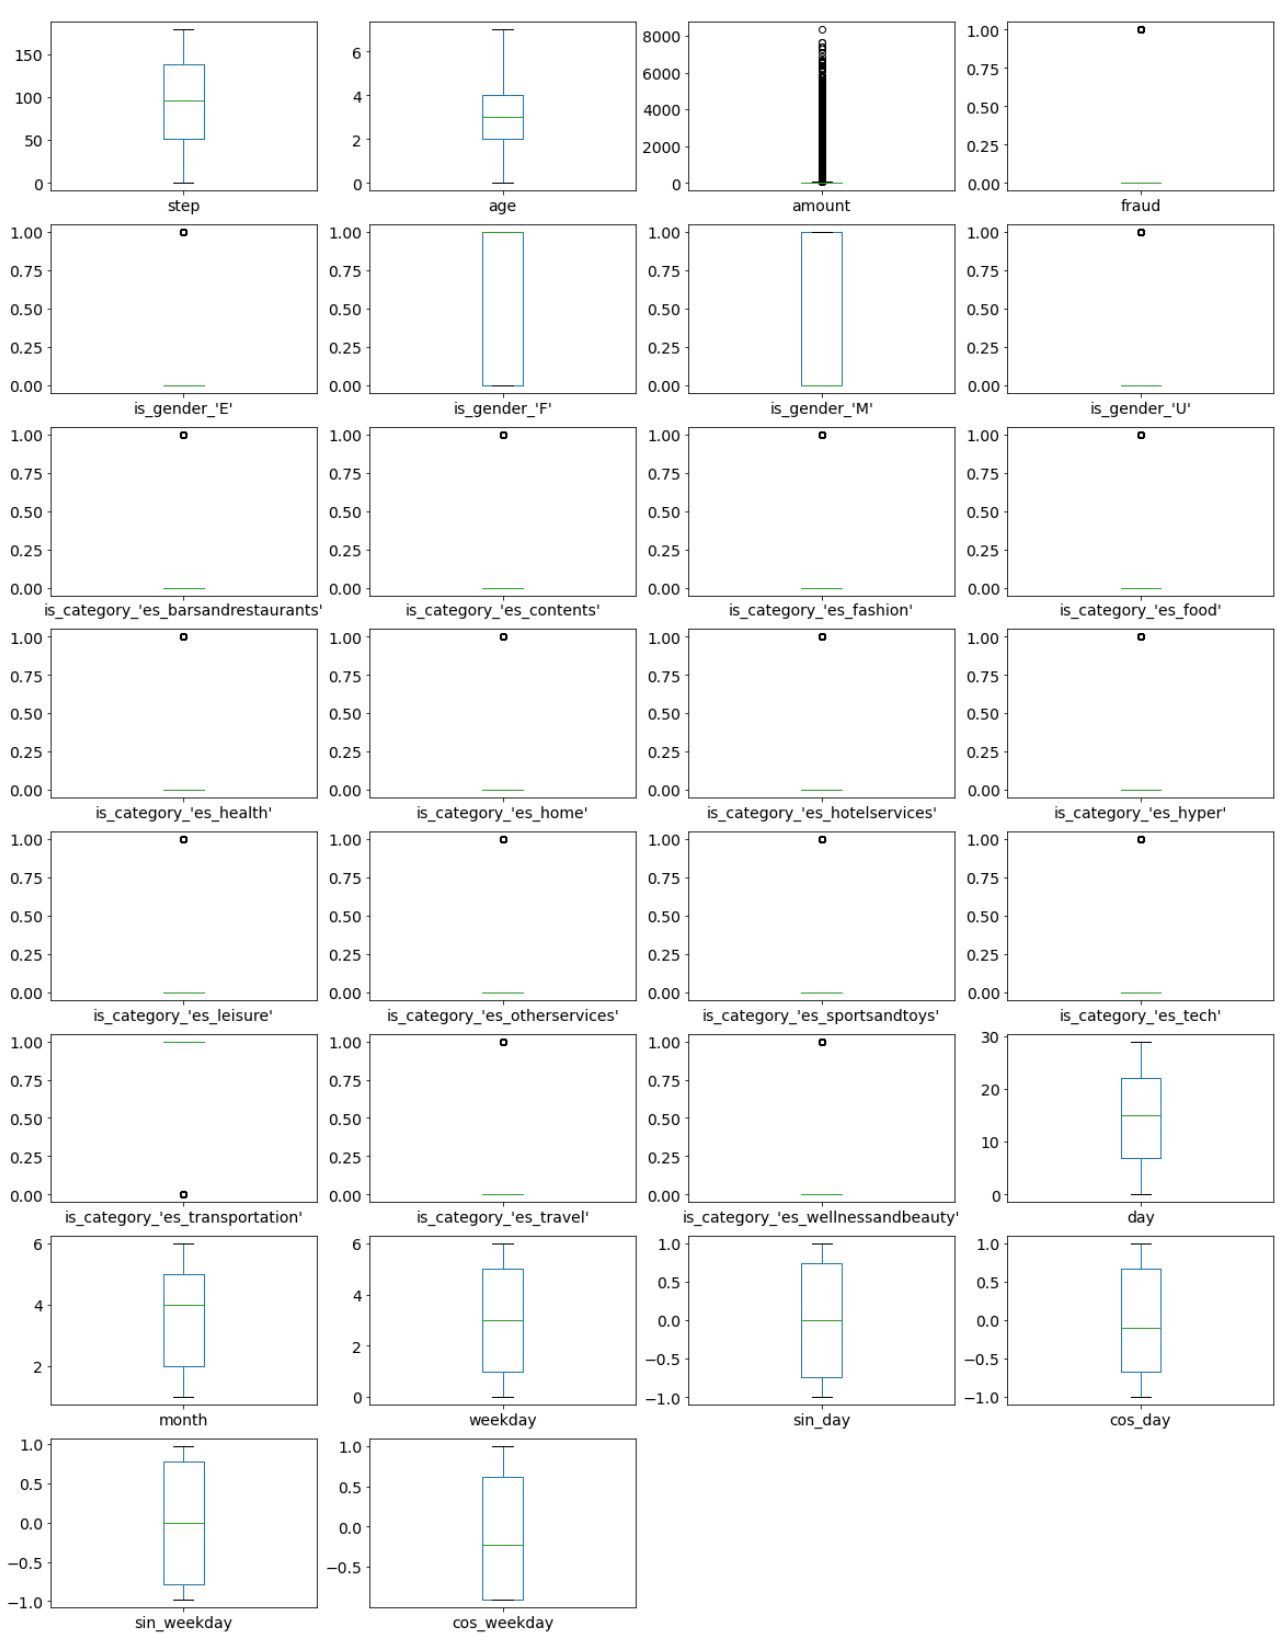
Figure 13. Extended BankSim dataset box